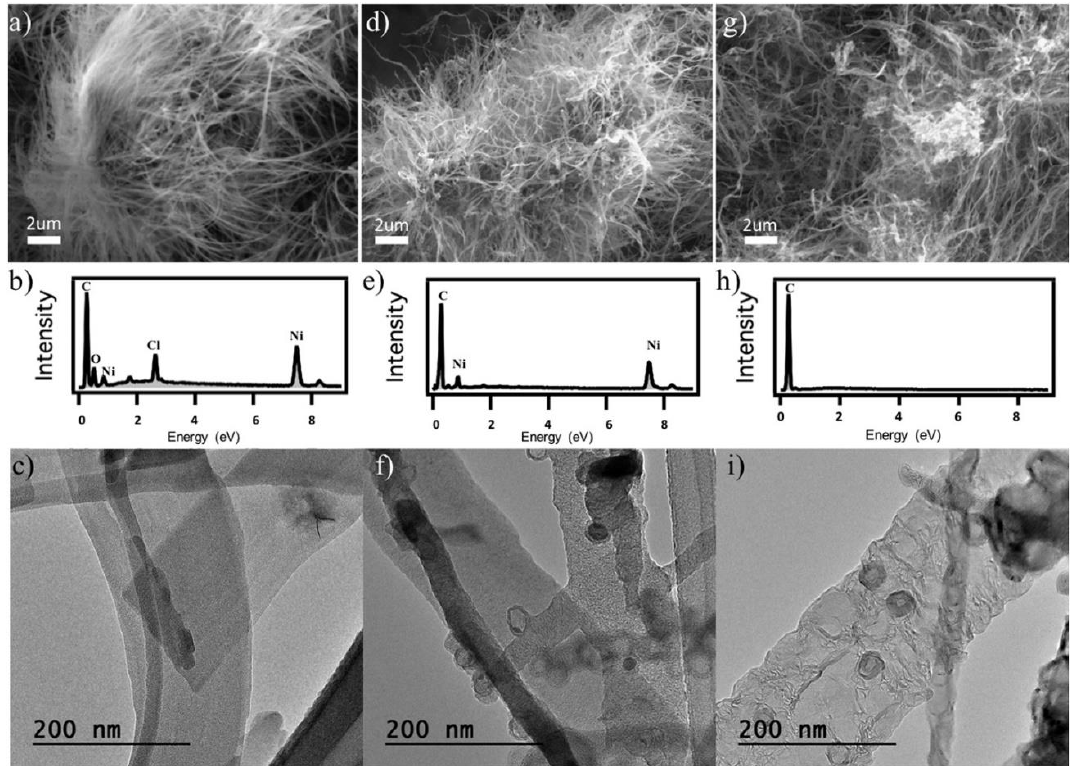
Figure 17. SEM images, EDS spectra and TEM images of ( a – c ) Ni-PTCDI aerogel, ( d – f ) Ni-CNF aerogel treated at 1050 °C, ( g – i ) Ni-CNF aerogel treated at 2000 °C, respectively. Reprinted with permission from [57]. Copyright © 2019 Elsevier Ltd.